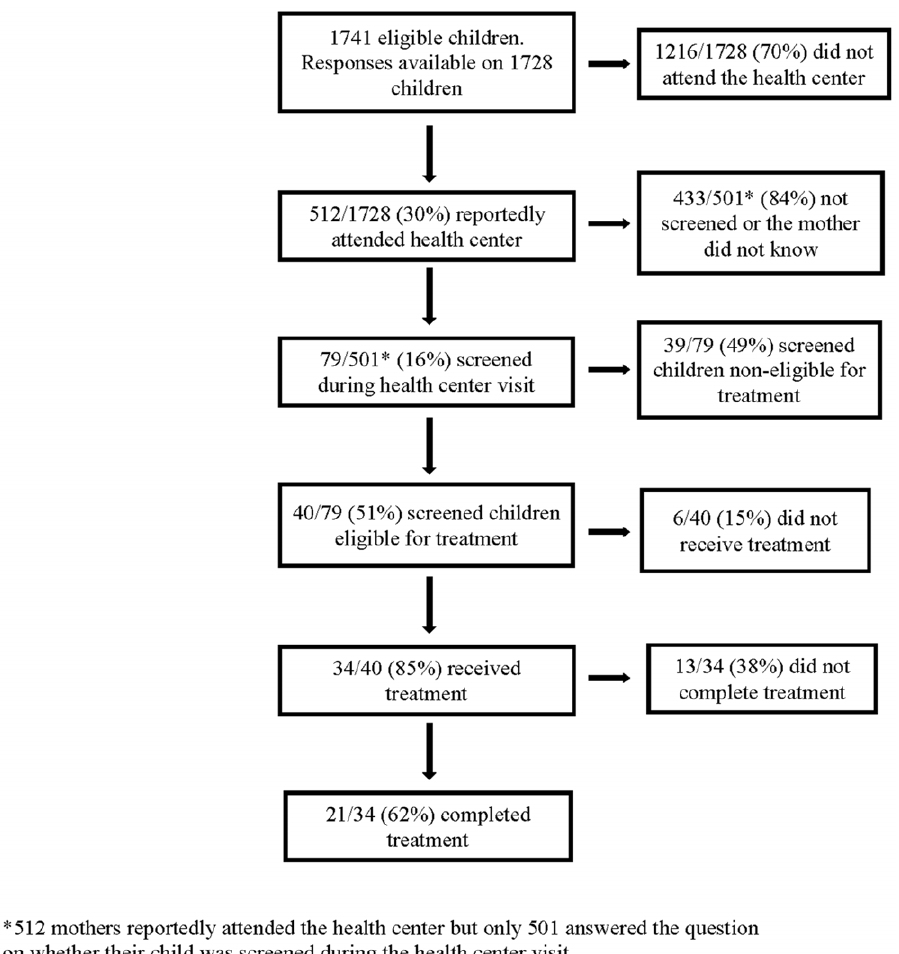
Figure 3. Screening for acute malnutrition at the health center.